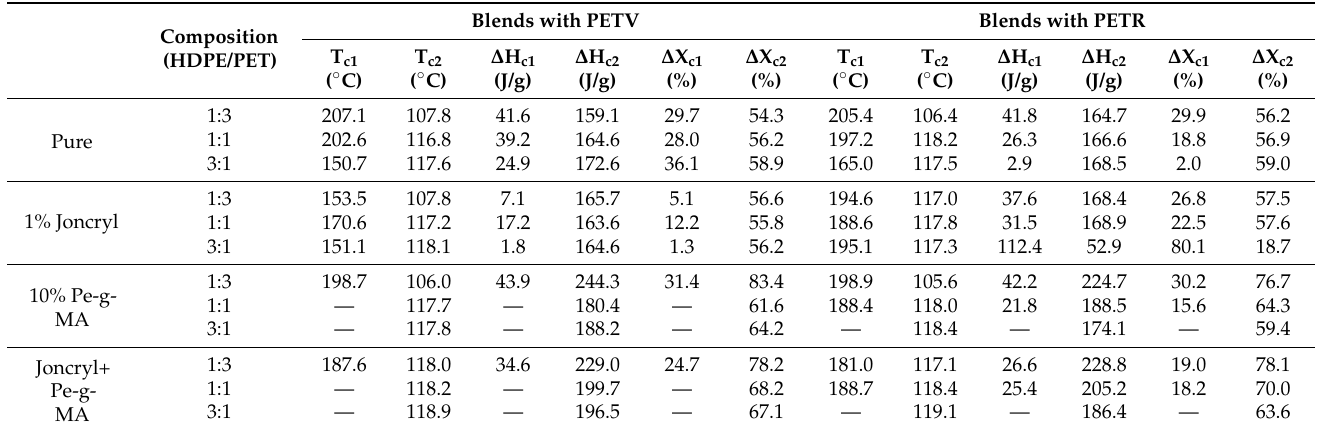
Table 3. Crystallization parameters of the neat, additivated, compatibilized and additivated and compatibilized